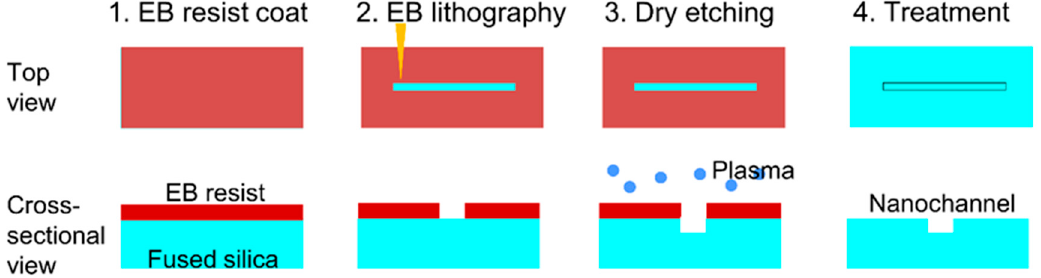
Figure 1. Schematic illustration of the nanochannel fabrication process.